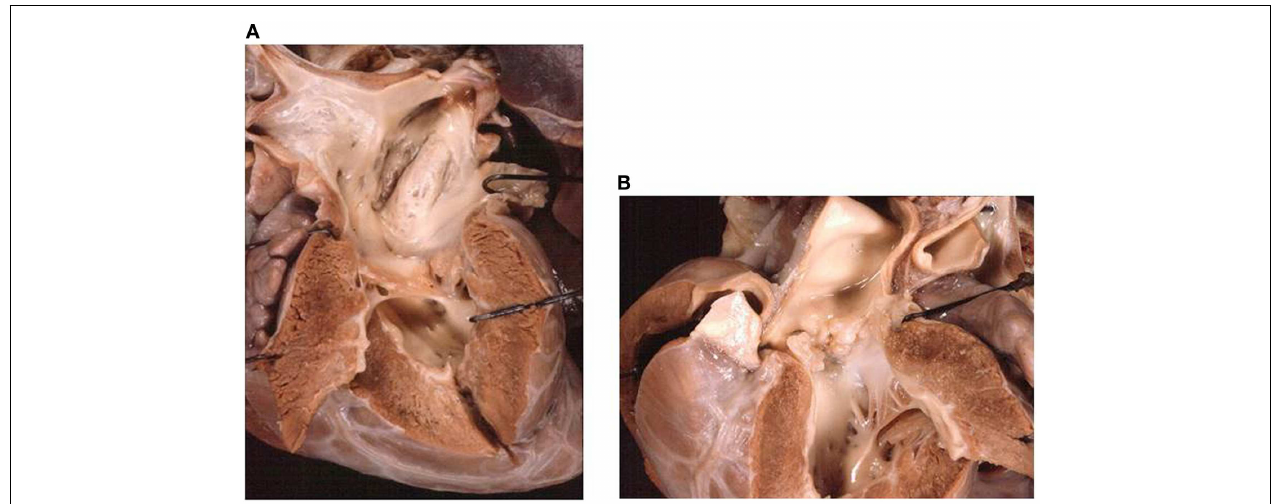
fibroelastosis of the left ventricle. (B) A severe aortic stenosis is present with dysplastic aortic valve.This heart may be amenable for one and half ventricle